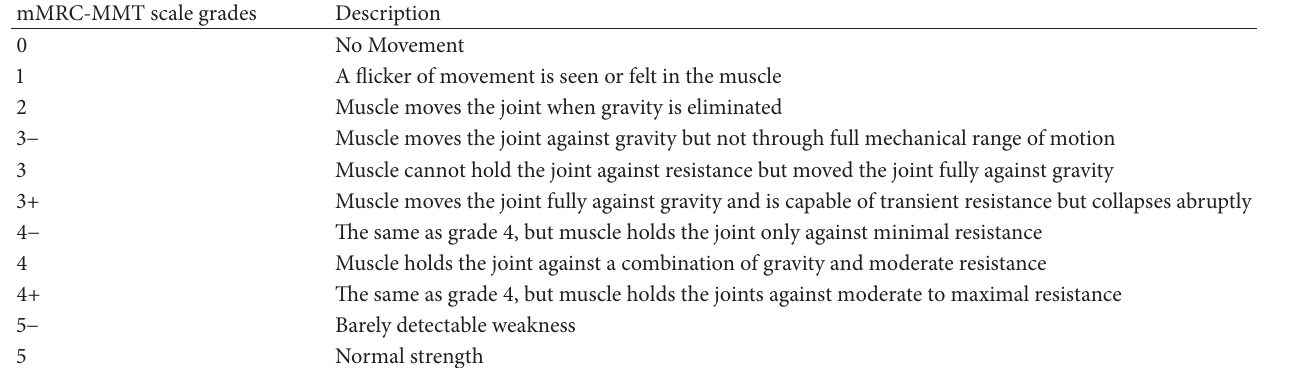
Table 1: Modified medical research council manual muscle testing scale. Florence et al, 1992